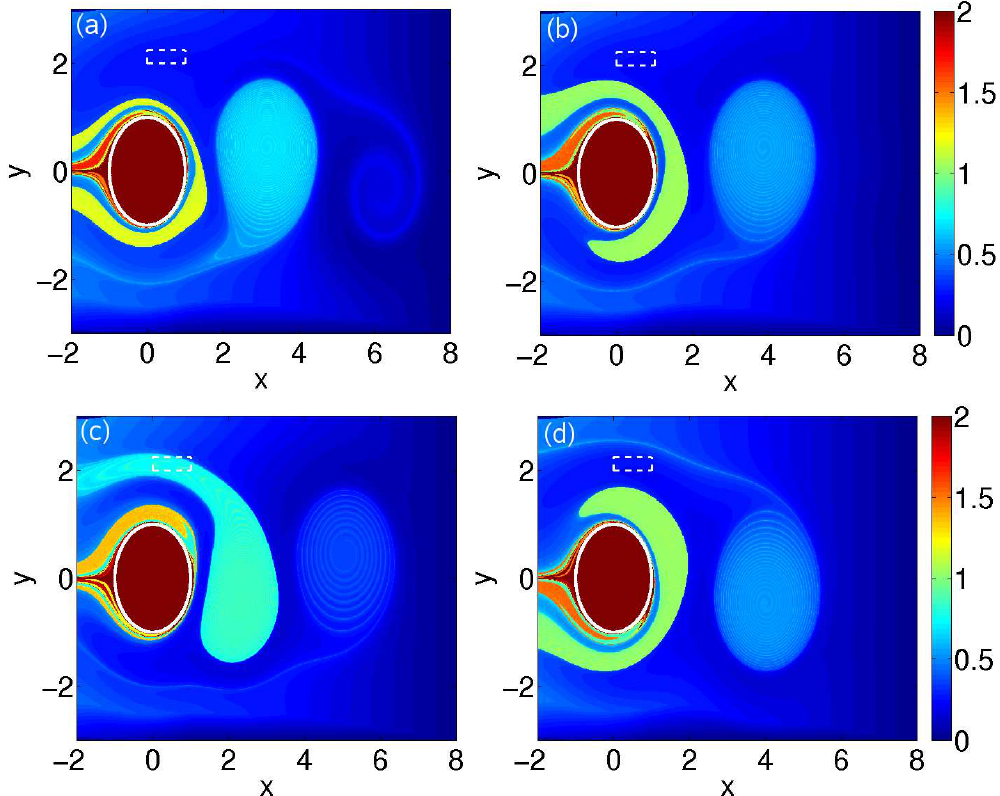
Fig. 11. Colors denote the forward residence times τ at t = 0 . 36 T c (a) , t = 0 . 48 T c (b) , t = 0 . 68 T c (c) , t = 1 . 00 T c (d) . The yellow-green region ( τ + res ( r ,t ) ≈ 1 . 2 ) in (a), the green region ( τ + res ( r ,t ) ≈ 1 ) in (b) and the light green region ( τ + res ( r ,t ) ≈ 0 . 8 ) in (c) are the areas of entrainment of the lower vortex. The overlap with the upwelling region (b) (dashed white rectangle) allows for entrainment of parcels crossing the upwelling region. The green area ( τ + res ( r ,t ) ≈ 1 ) in (d) shows the area of entrainment of the upper vortex. This area does not overlap with the upwelling region (dashed white rectangle) for all times. Thus, entrainment of parcels crossing the upwelling region is not possible for the upper vortex.